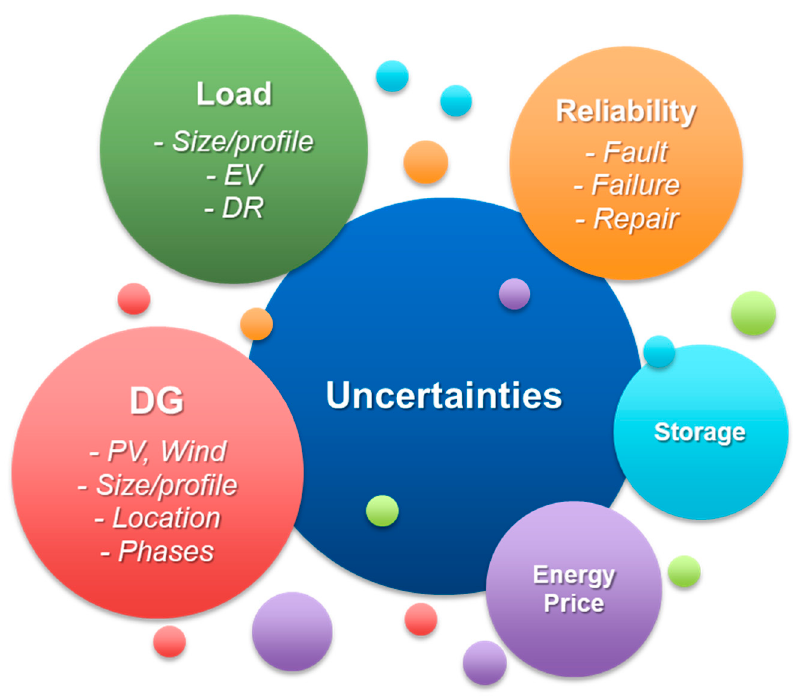
Figure 7. Main uncertainties observed in the literature review.